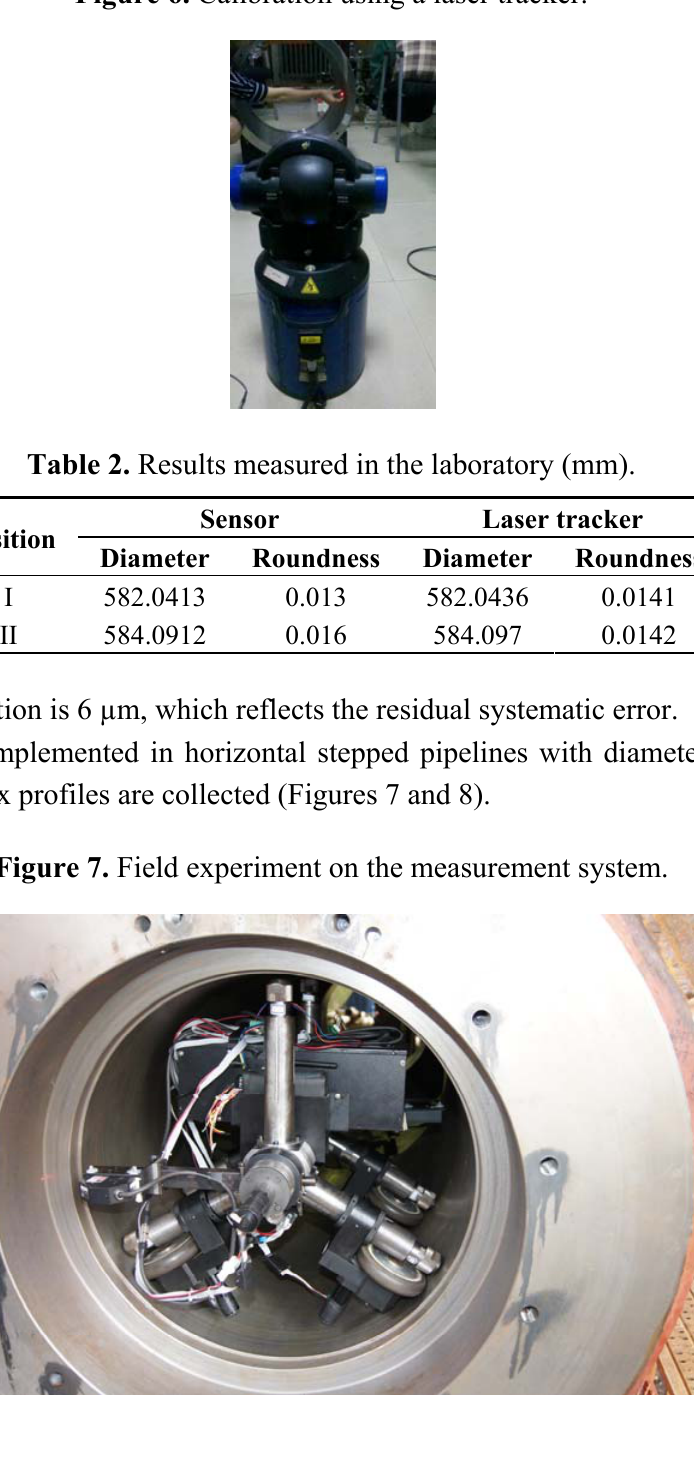
Figure 6. Calibration using a laser tracker.